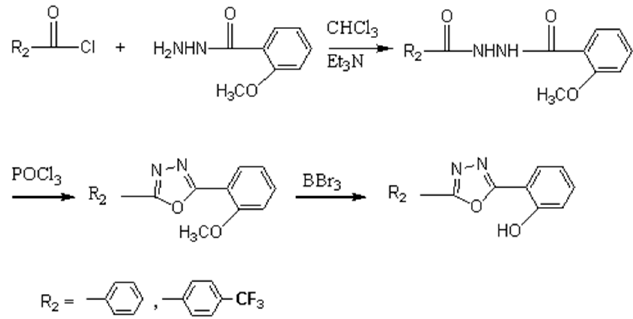
Figure 1. Synthesis routes of 2 ‐ (5 ‐ phenyl ‐ 2 ‐ ( ‐ 1,3,4) ‐ two ‐ radical) ‐ phenol ‐ auxiliary ligands.